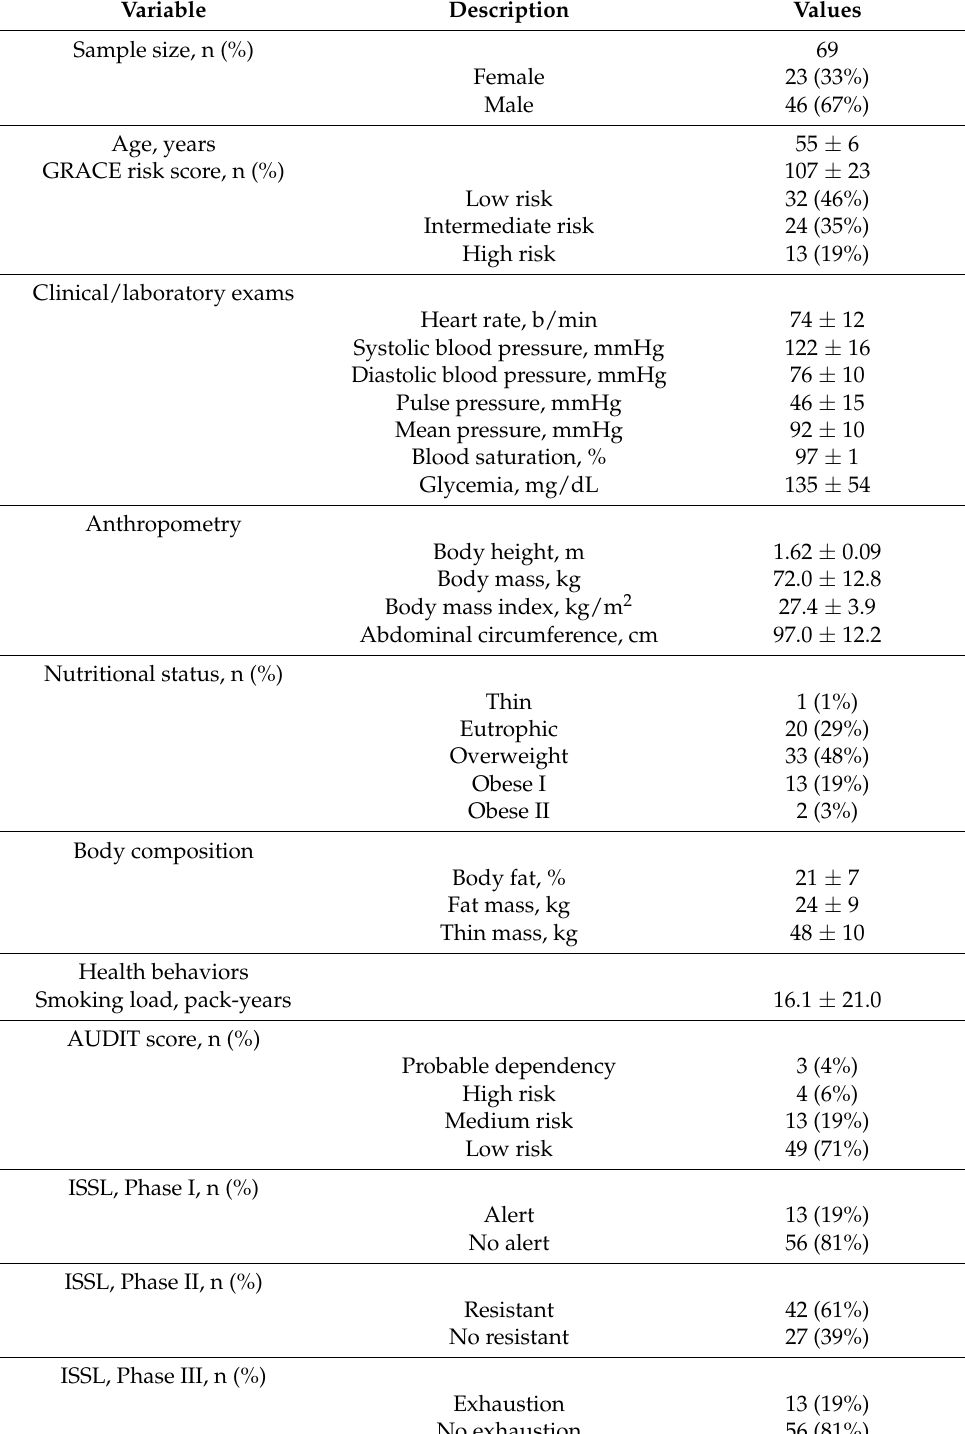
Table 1. Descriptive analysis of the sample of patients hospitalized for acute coronary syndrome in the cardiology